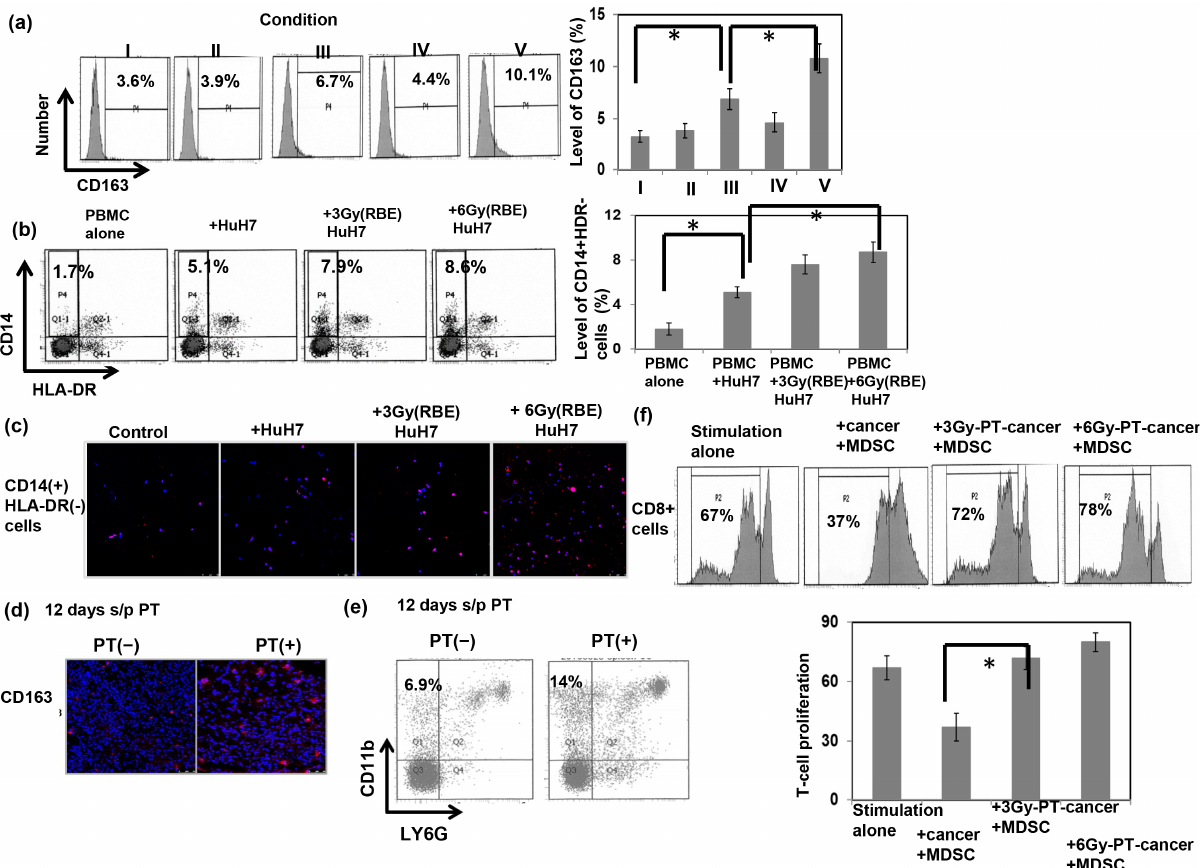
Figure 4. Immune response associated with PT. The expression of the CD163 marker in the cells at the end of M2 macrophage polarization was analyzed via FACS ( a ) (I: control; II: + cancer cell culture supernatant; III: + cancer cells; IV: +6 Gy (RBE) PT-irradiated cancer cell culture supernatant; V: +6 Gy (RBE) PT-irradiated cancer cells). The percentage of CD14+HLA-DR − cells from PBMCs incubated with or without HuH7 cells irradiated with 0, 3, or 6 Gy (RBE) for 48 h was analyzed ( b ), and the expression of iNOS in the sorted CD14+HLA-DR − cells was analyzed via IF (DAPI, blue; iNOS, red) ( c ). The extent of CD163+ cells in irradiated tumors 12 days after PT was examined via IF (DAPI, blue; CD163, red) ( d ), and the effect of PT irradiation on monocytic-MDSC recruitment was evaluated via FACS ( e ). Furthermore, the rate of T-cell proliferation was examined via FACS with or without incubation with PT-irradiated cancer cells. Representative images and quantitative data are shown ( d ). Treatment indicated CD8+ T cells with anti-CD3/CD28 stimulation beads in the presence of MDSC combined with cancer cells with or without PT irradiation. Data are presented as means ± standard errors of the mean. * p < 0.05.